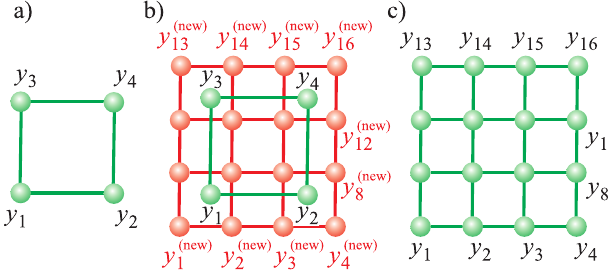
Figure 9. Increasing the Growing SOM (GSOM)’s structure: ( a ) before. ( b ) during, and ( c ) after performing a single step of the